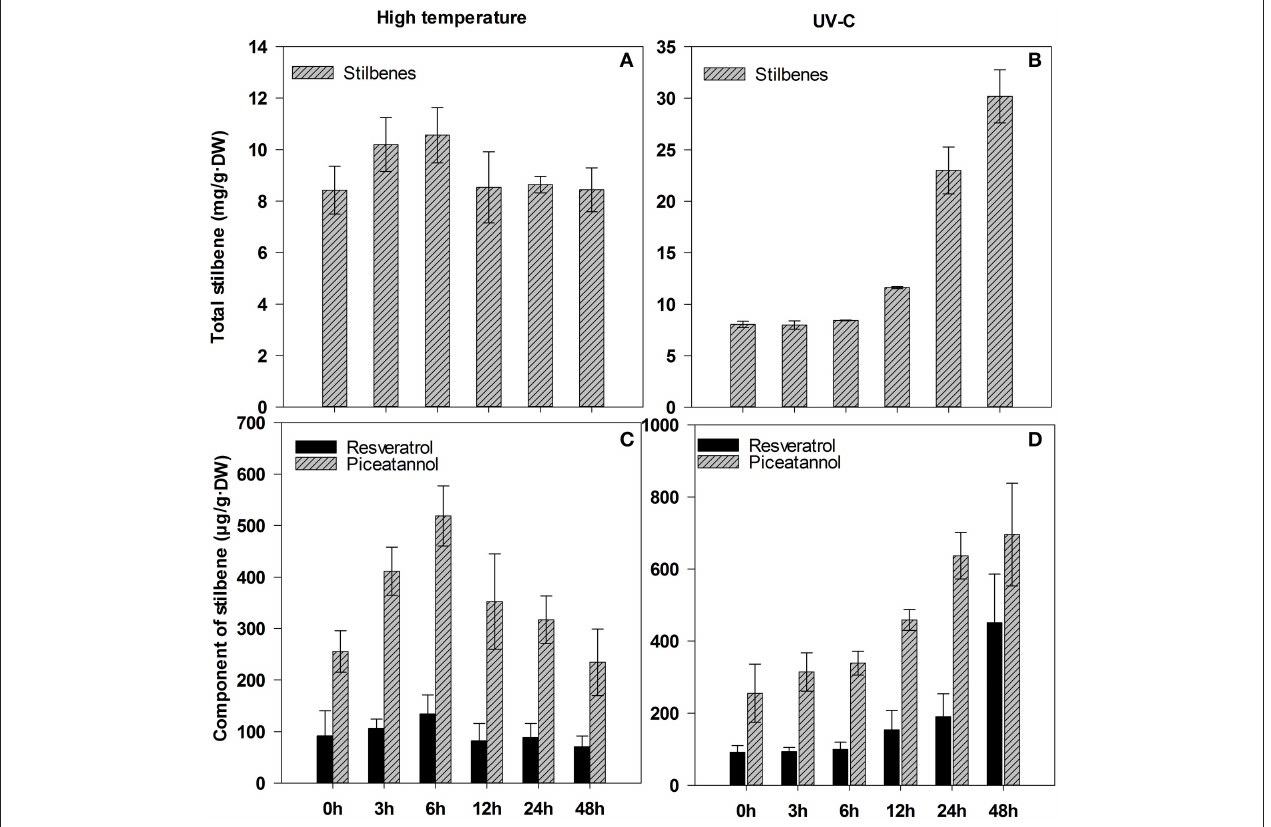
FIGURE 8 | Content of total stilbenes and its components in leaves of Gnetum parvifolium seedlings under stresses. (A) and (B) report total stilbenes under high temperature and UV-C, respectively; (C) and (D) report component of stilbenes under high temperature and UV-C, respectively. Young seedlings were treated with high temperature (40 ◦ C)/UV-C, respectively, for 0, 3, 6, 12, 24, and 48h. Vertical bars represent the mean ± SD of four separate